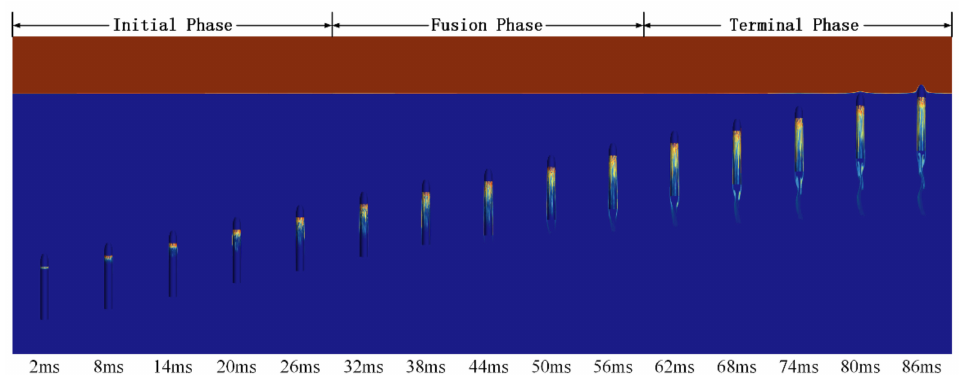
Figure 11. Three stages of air film